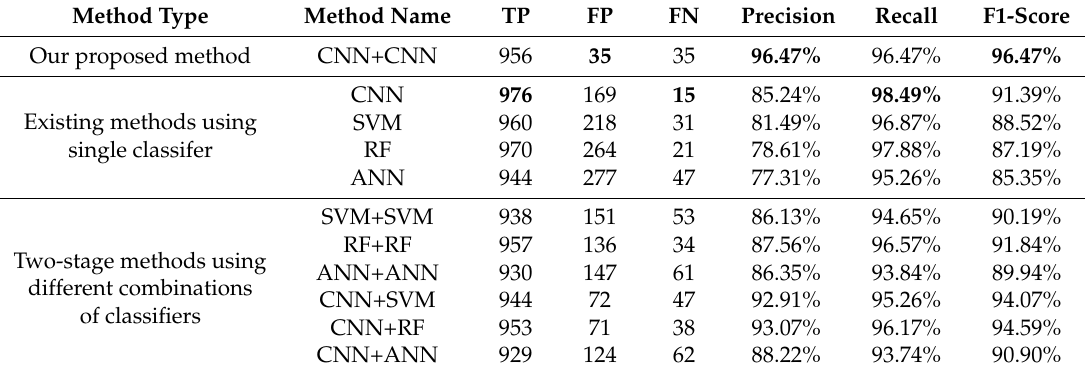
Table 5. The detection result of each method in Region 3.